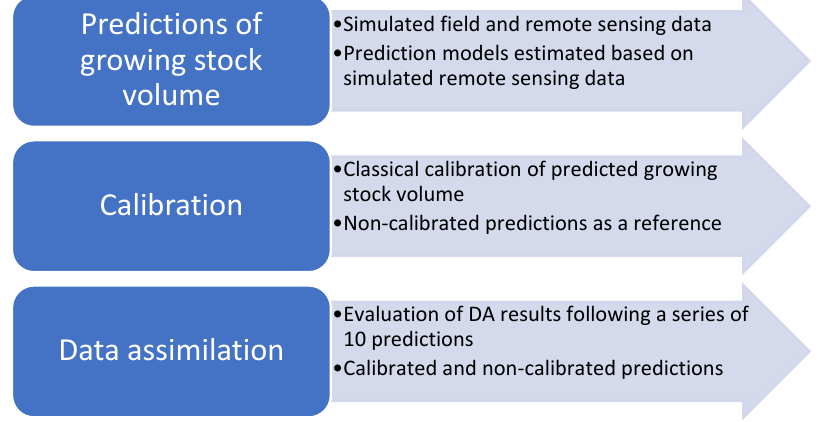
Figure 1. An overview of the different parts of the study.